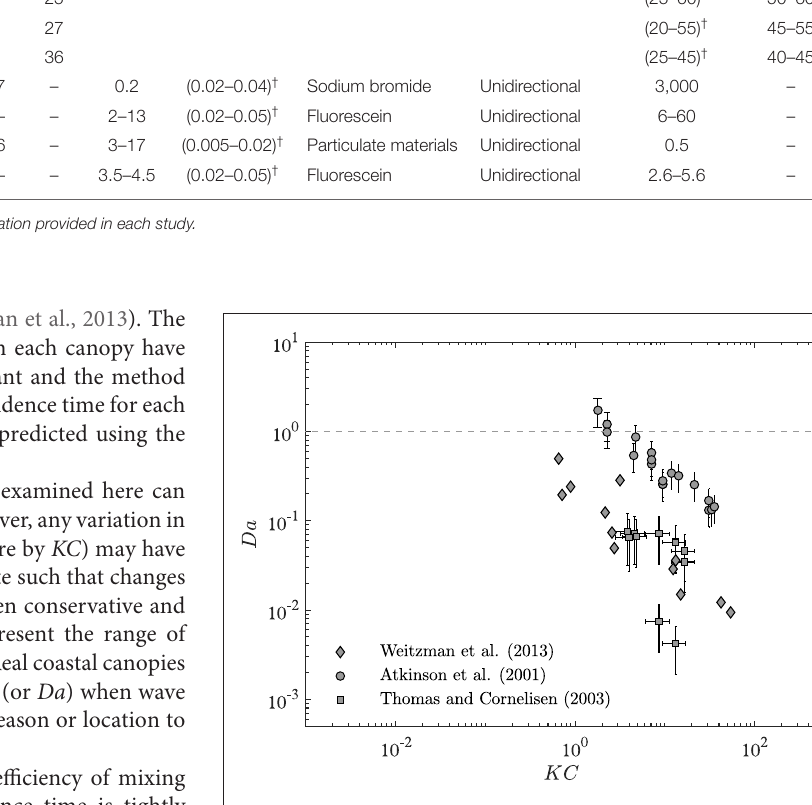
FIGURE 6 | Variation of Damköhler number ( Da ) with Keulegan-Carpenter number ( KC ). Values of Da calculated for nutrient uptake in canopies of corals ( Atkinson et al., 2001), seagrasses (Weitzman et al., 2013), and macroalgae ( Thomas and Cornelisen, 2003). Changes in wave and canopy properties (represented here by KC ) lead to variation of nutrient uptake from dynamic to conservative environment. Vertical bars represent the standard deviation of Da